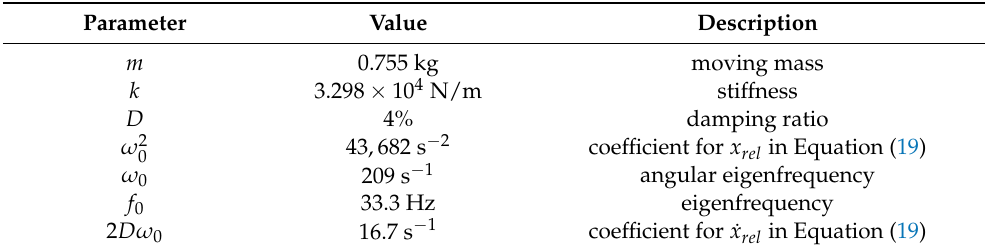
Table 3. Theoretical parameters of the oscillator, modified from